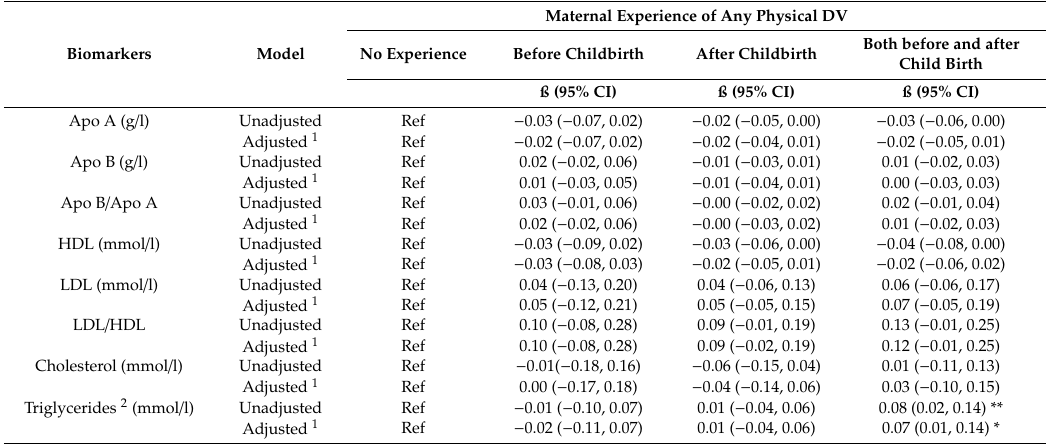
Table 3. Association of children’s level of lipid biomarkers with maternal experience of any physical DV before and after childbirth.